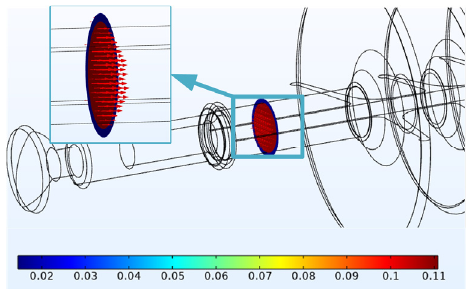
Figure 11. Current-density distribution of #1.